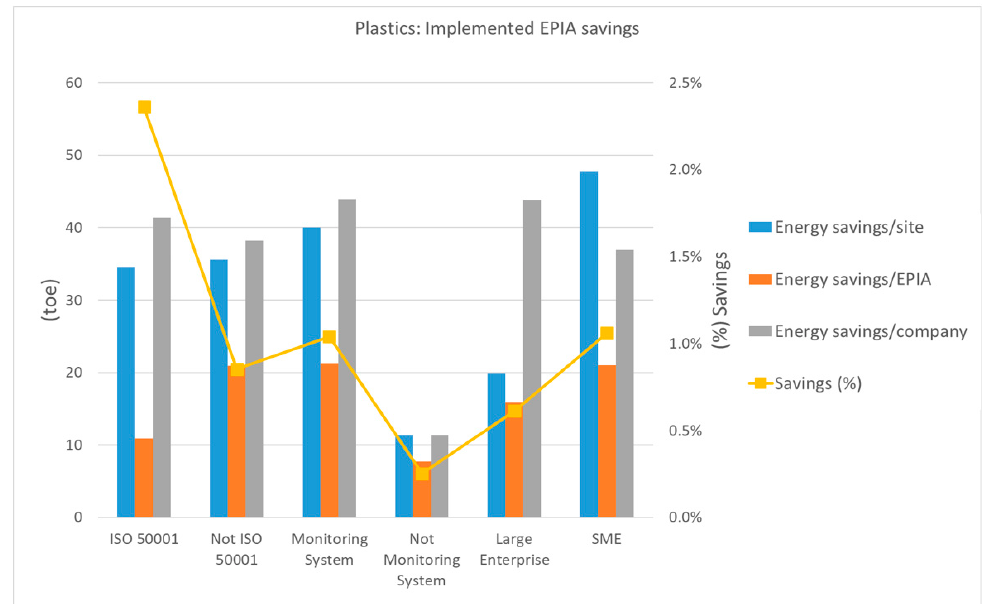
Figure 4. Plastics: implemented EPIA savings.